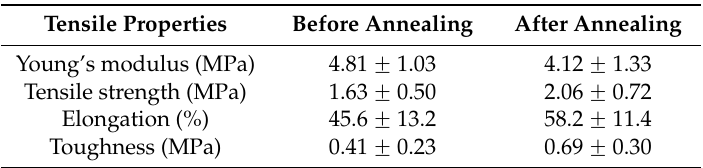
Table 2. Tensile properties of nylon 6 non-woven fiber mats electrospun from 20 wt % and 10 wt % solutions before and after annealing at 70 ˝ C for 24 h.